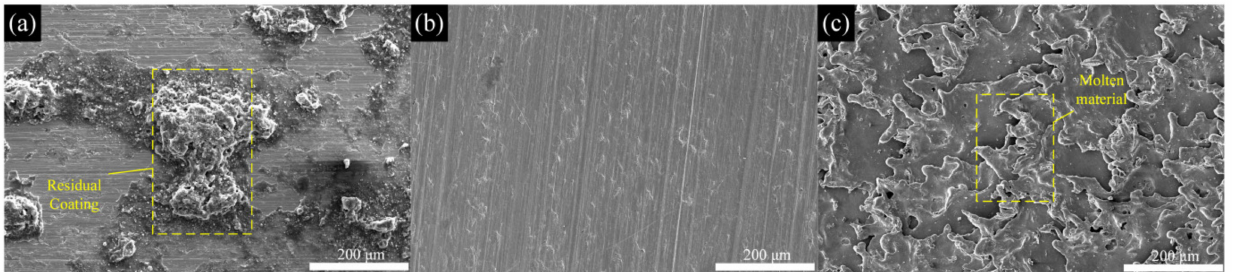
Figure 6. SEM of the cleaning surface at different water jet-guided laser energy densities. ( a ) Coating residual stage; ( b ) Coating removal and no damage to the substrate stage; ( c ) Substrate damage